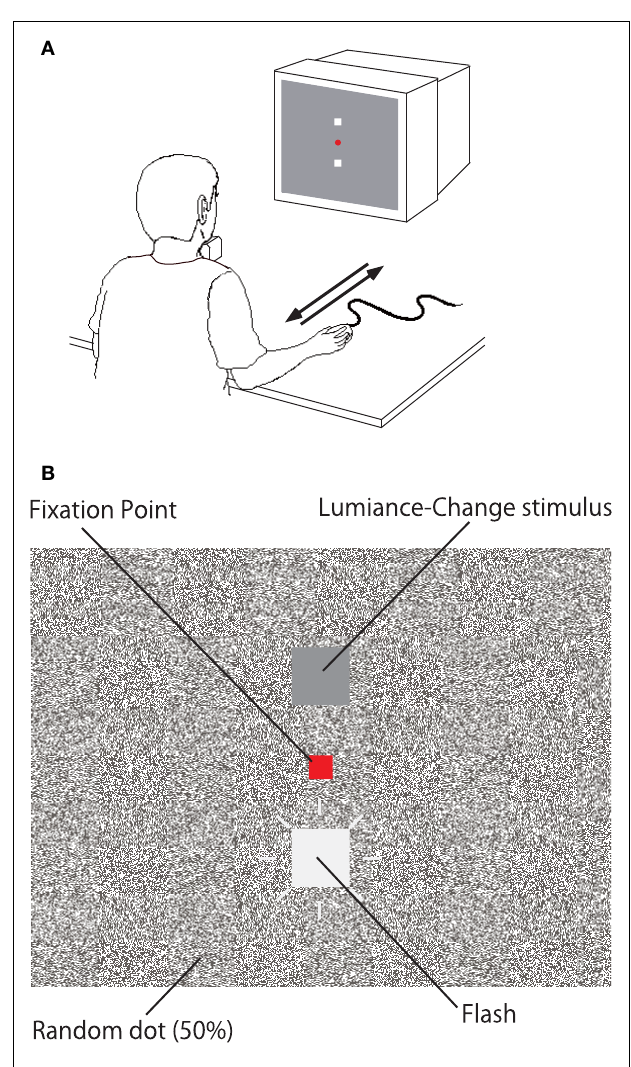
FIGURE 1 |Apparatus for Experiment 1. (A) In the Manual condition, the forward (or backward) movement of the computer mouse on the desk was coupled with the decrement (or increment) of the luminance in the luminance change stimulus. (B) Display used in Experiment 1.